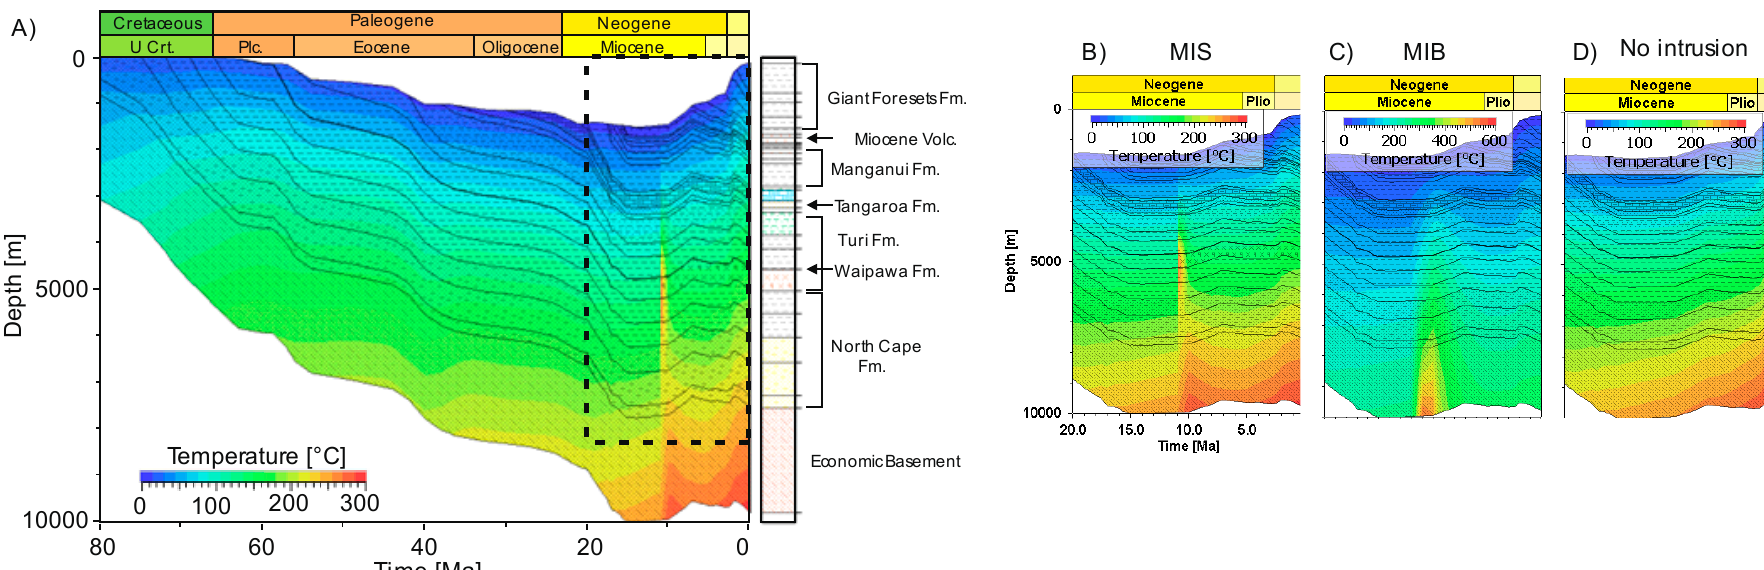
Figure 10. ( A ) Burial history with temperature overlay for Kora-4 well with intrusion emplacement at 11 Ma in Paleocene and Late Cretaceous layers. ( B ) Temperature changes in the surrounding sediments affected by intrusion emplacement. ( C ) Temperature changes for the time span 0 to 15 Ma for the scenario with deep seated intrusion placed at 11 Ma. ( D ) Temperature changes for the time span 0 to 15 Ma for the scenario without intrusion. MIS = magmatic intrusion in sediments; MIB = magmatic intrusion in basement.